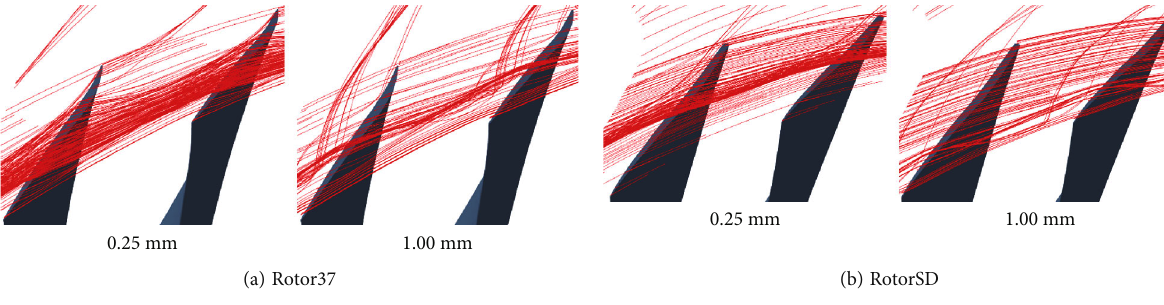
Figure 30: Leakage fl ow streamlines at 97% clearance